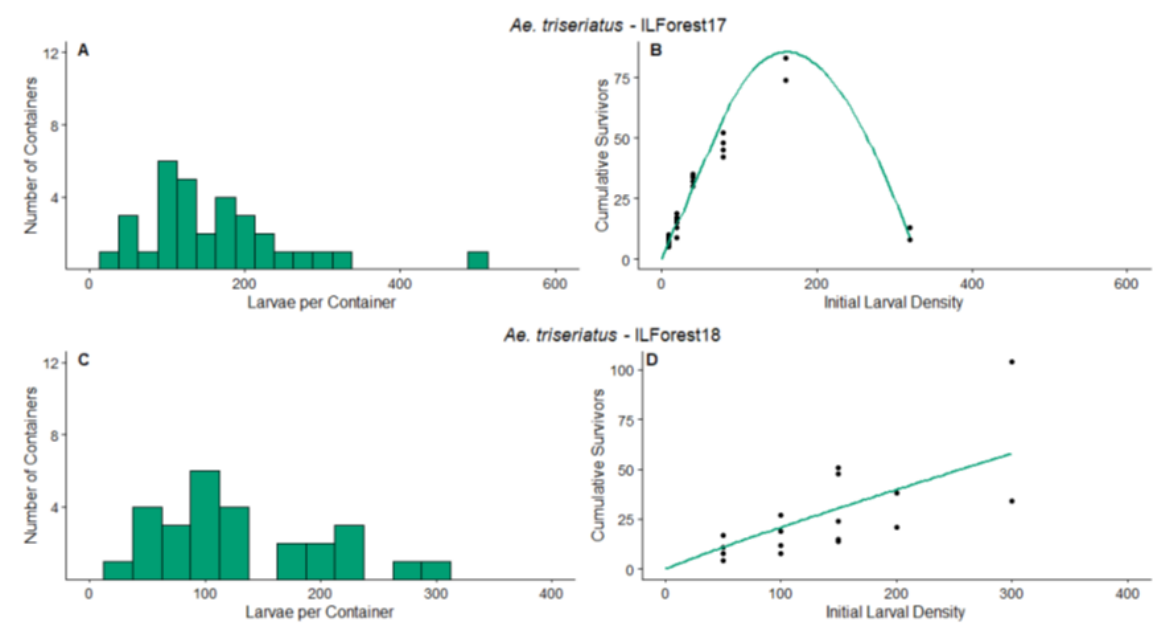
Figure 2. Results for ILForest17 and ILForest18 experiments. The left panels are the frequency distribution of mosquito larvae per container at the end of the survey periods, ( A ) for ILForest17, ( C ) for ILForest18. The points on the right panels represent the cumulative number of survivors on the final census day of the density manipulation experiments, ( B ) for ILForest17, ( D ) for ILForest18. The lines on the right panel represent the predicted values for the relationship between initial larval density and cumulative survivors, according to the non-linear regression analyses. Green indicates that the experiment was conducted on Ae. triseriatus . Axis values vary between